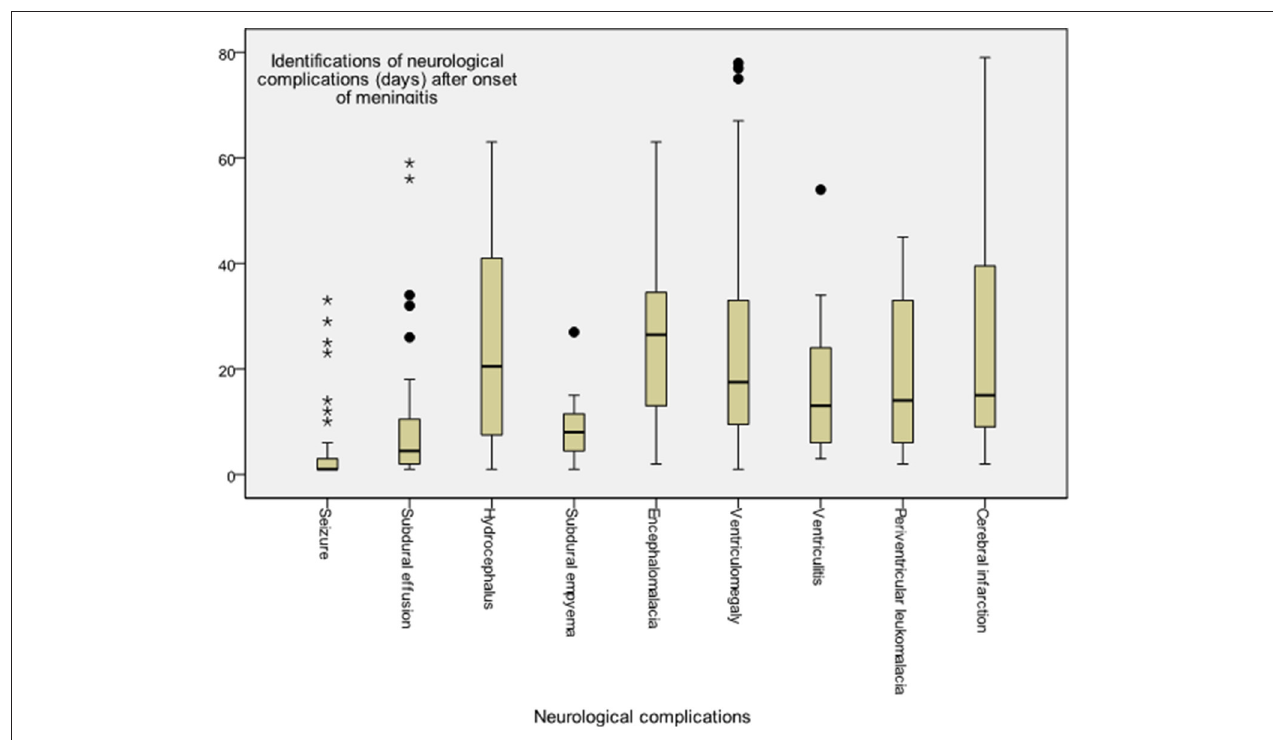
FIGURE 2 | Time to diagnosis of various neurological complications in young infants with acute bacterial meningitis. Meningitis onset was defined as when the cerebrospinal fluid culture sampling was obtained, whereas onset of neurological complication was defined at the symptom presentation or diagnosis by neuroimaging